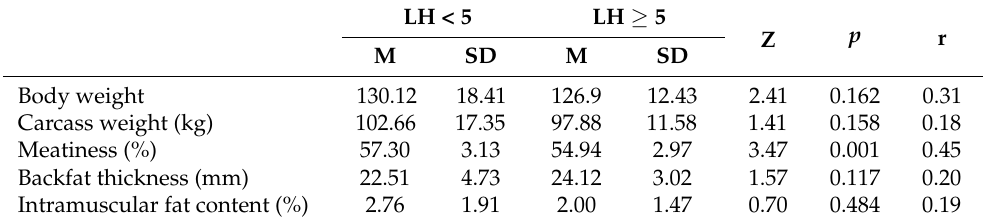
Table 5. Influence of luteinizing hormone level (mlU/mL) on selected slaughter parameters of gilt carcasses.